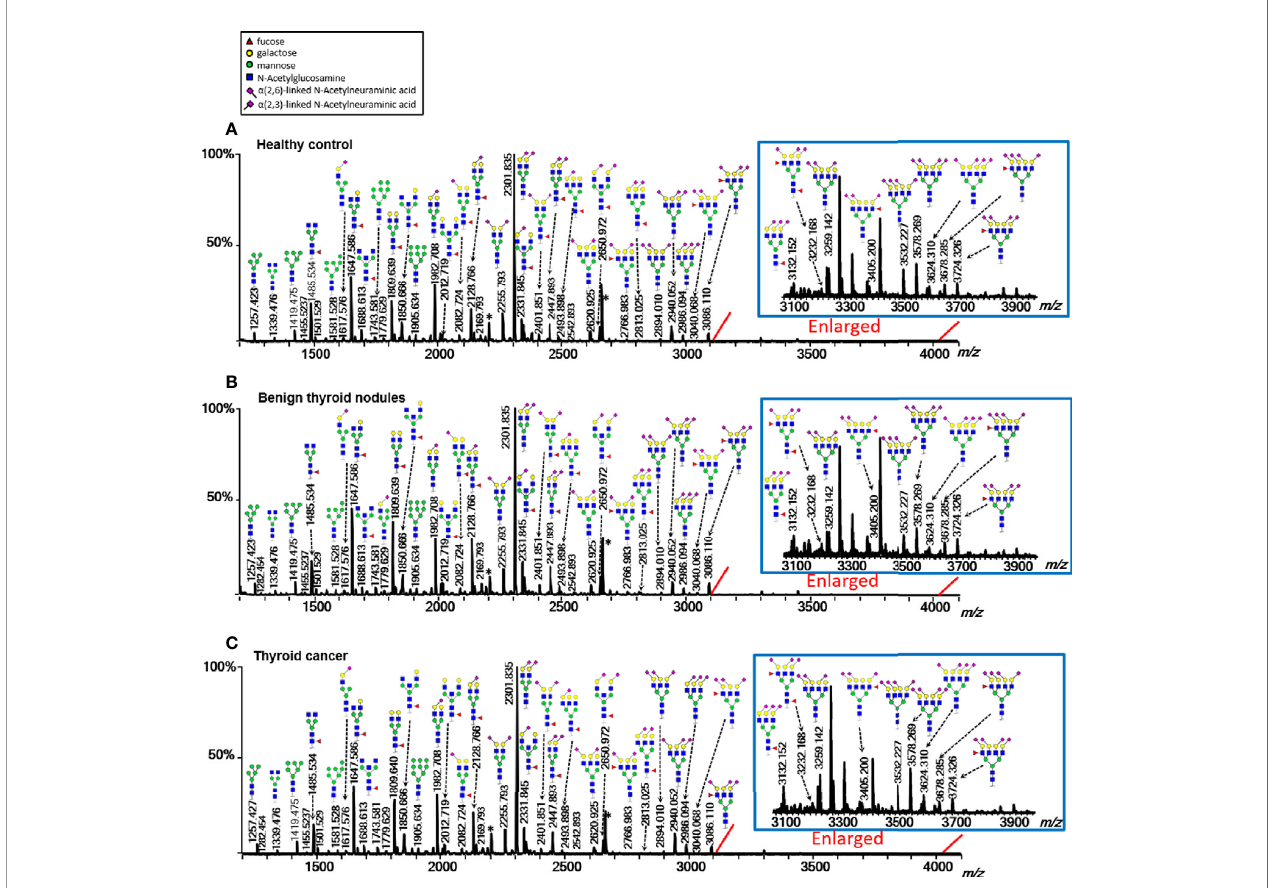
FIGURE 2 | Typical MALDI-TOF-MS spectra of plasma protein N -glycome for (A) healthy control, (B) benign thyroid nodules, and (C) thyroid cancer. Spectra were recorded in positive-ion re fl ectron mode on a Bruker rapi fl eXtreme mass spectrometer. Major N -glycan peaks were annotated and assigned to compositions and the presence of structural isomers cannot be excluded. The asterisk (*) are